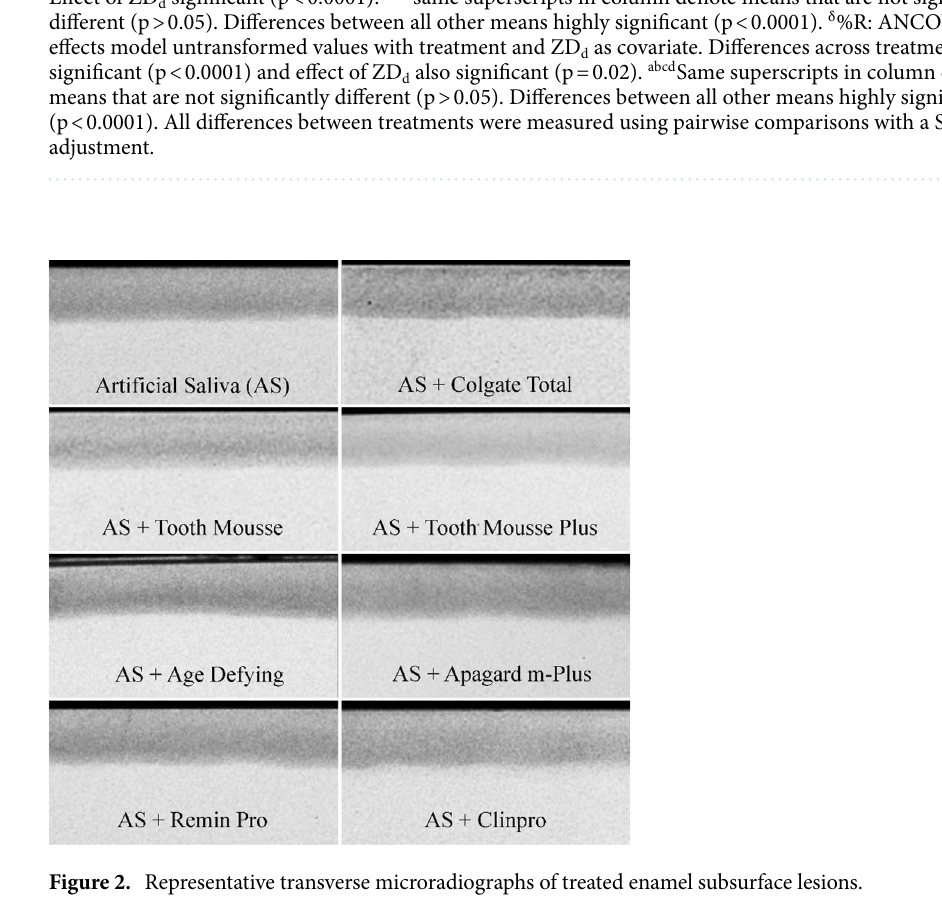
Figure 2. Representative transverse microradiographs of treated enamel subsurface